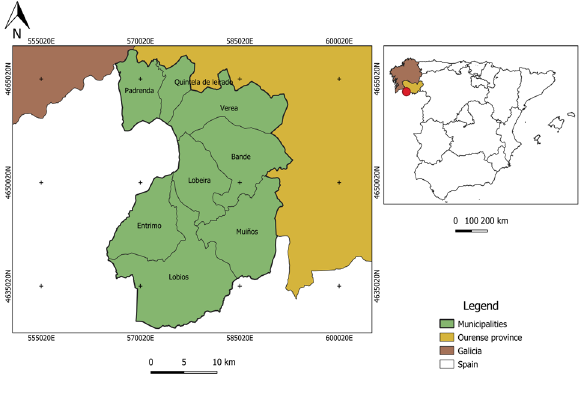
Figure 1. Location of the area of study. The map coordinate system is EPSG:25829 ETRS89/UTM zone